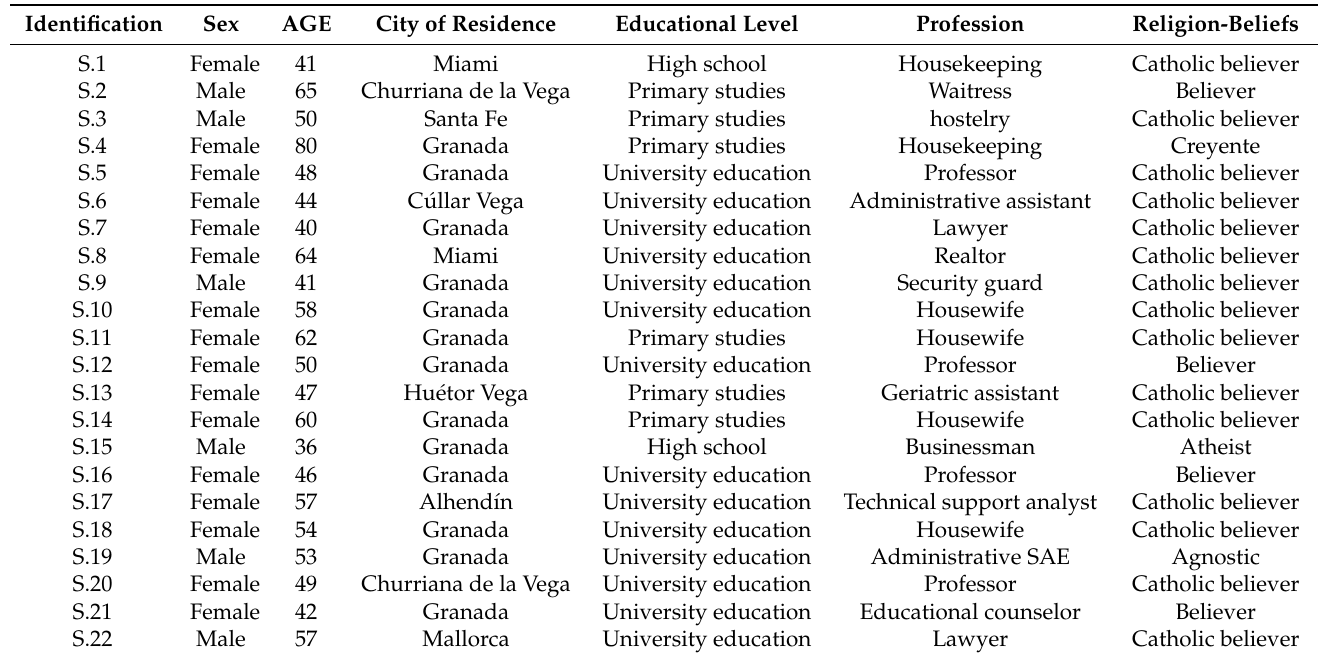
Table 1. Identification sheet of